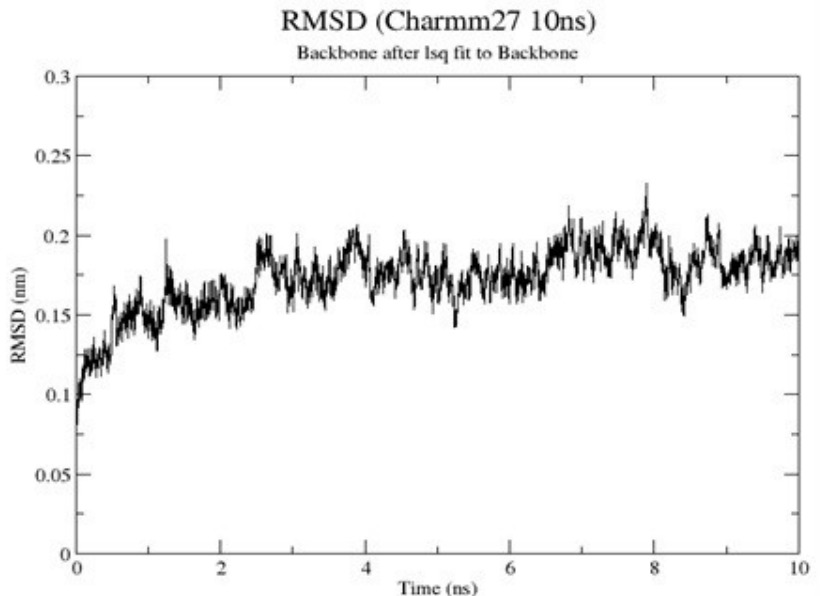
Figure 2. Root-mean-square deviation (RMSD) of the MD simulation of HIV-1 gp120 monomer using GROMACS. A plot of RMSD in nanometers (nm) against time in nanoseconds (ns). The RMSD increased from 0 ns to 1 ns and fluctuated till 9 ns, after which it stabilized till the end of the simulation.